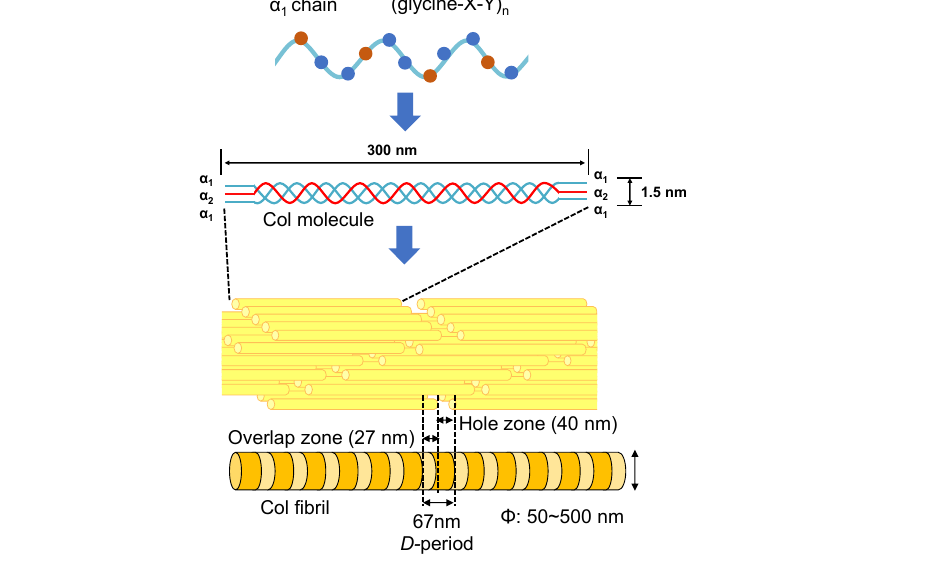
Figure 4. The structures of Col molecules and their various aggregation states.